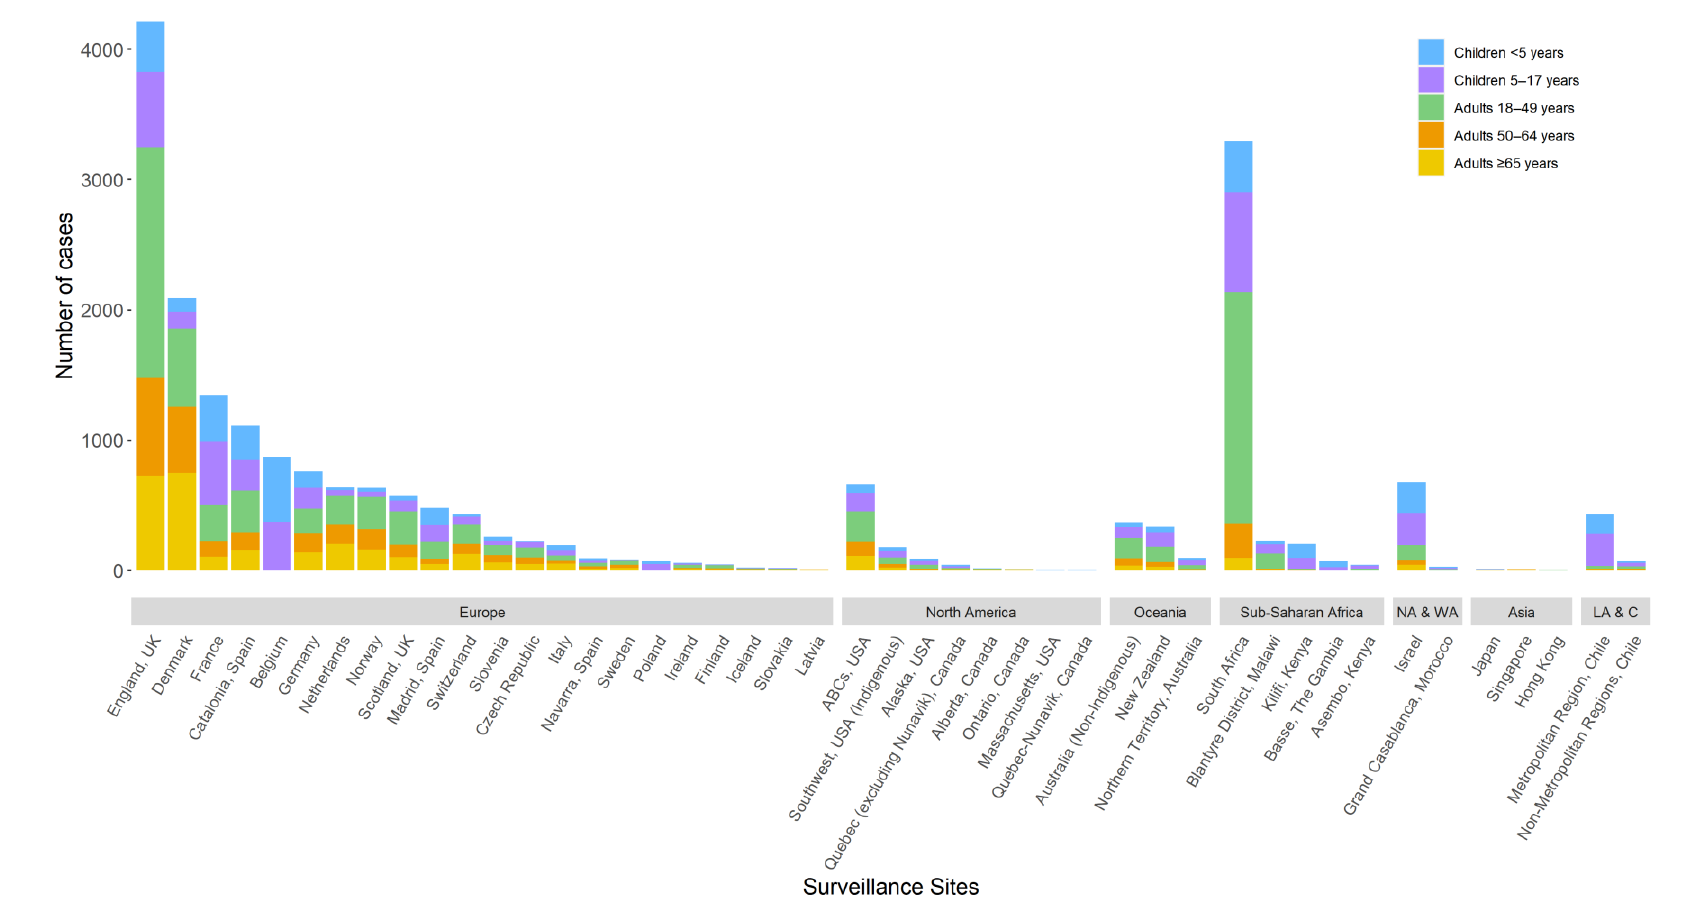
Figure 1. Number of serotype 1 cases per site included in the analysis by region and age group. NA & WA–Northern Africa and Western Asia; LA & C–Latin America and the Caribbean. Not all age groups were included for all sites (Table S1). Analyses were done with minor changes to age groups for certain sites to align with availability of population denominators and age groups provided by sites in aggregate: the <5 years age group includes 0–5 years from Morocco; the 5–17 years age group included 5–14 years from Japan and Kilifi, Kenya, 5–15 years from Germany, 6–14 years from Morocco, and 5–19 years from Australia and Malawi; and the 18–49 years age group includes 15–49 years from Japan and Kilifi, Kenya, 15–59 years from Morocco, 16–49 years from Germany, and 20–49 years from Australia and Malawi.